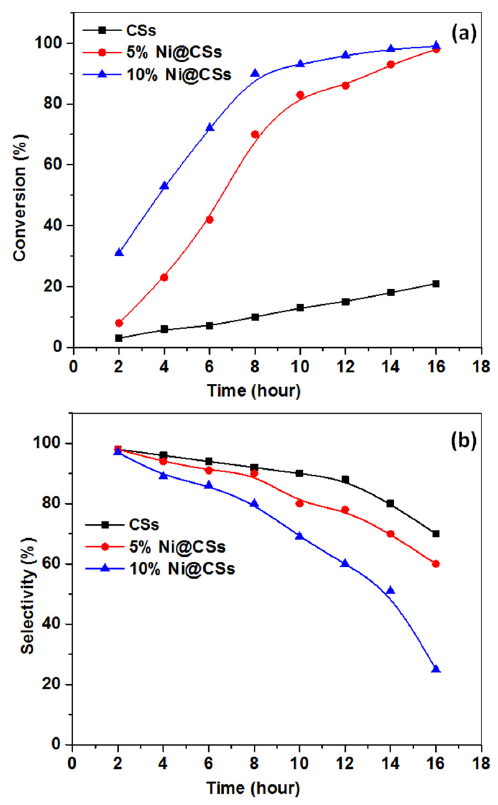
Figure 4. ( a ) Conversion (%) of cyclohexene, and ( b ) selectivity (%) of cyclohexene oxide using 10% Ni@CSs composite (50 mg catalyst, 353 K, pH = 8, and 14